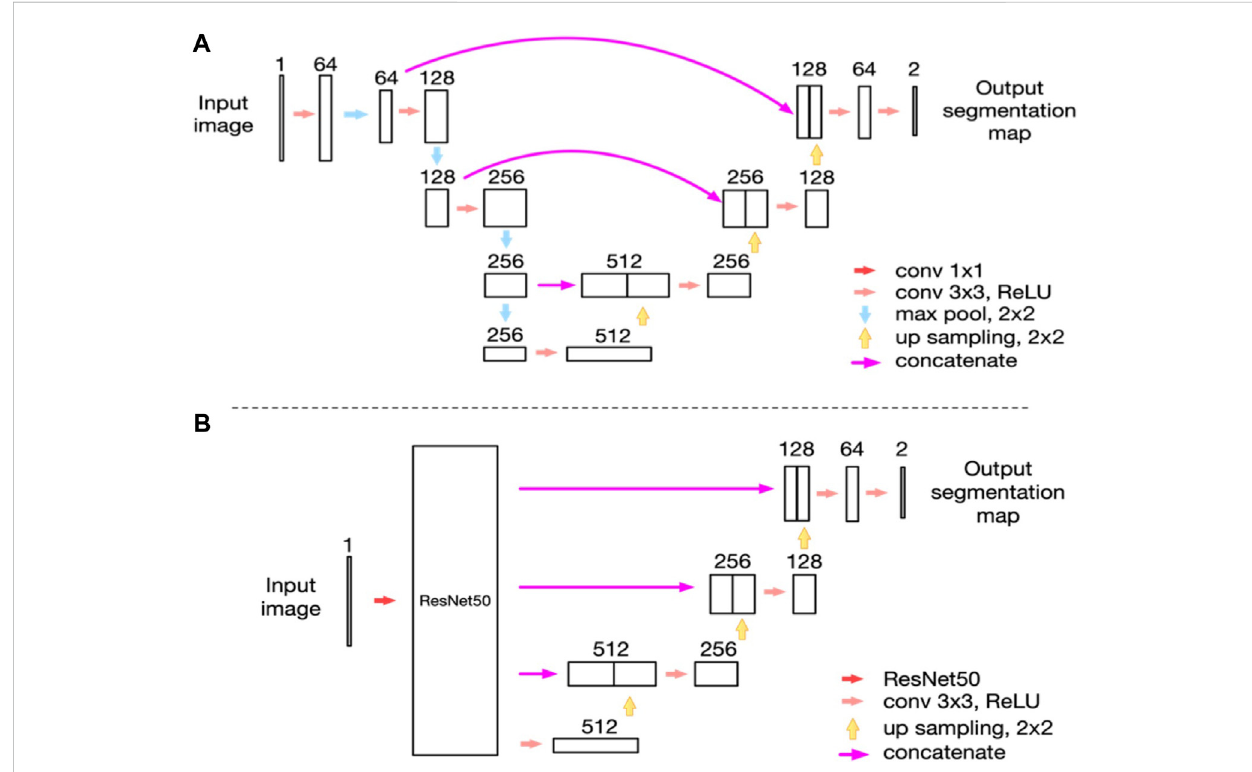
FIGURE 5 Networkstructure(Zhangetal.,2022b). (A) Thenetworkstructureofthemodi fi edU-netmodelaswereportedpreviously; (B) Thenetworkstructure of the ResNet50_U-net model in this